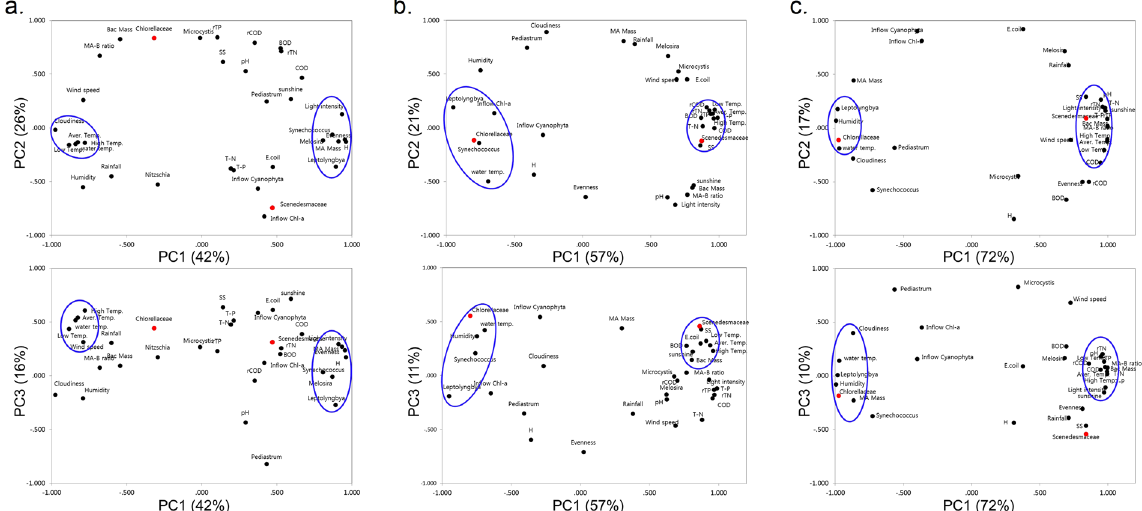
Figure 3. A 36-component 2D-PCA scatter plot based on correlation coefficients of all factors before ( a ), after ( b ) and during ( c ) temperature control experiments in HRAP. High correlation coefficient cluster is represented by bold blue line circle whereas dominant microalgal groups can be seen as red spots. The PCs were selected based on Scree plot and without rotation.